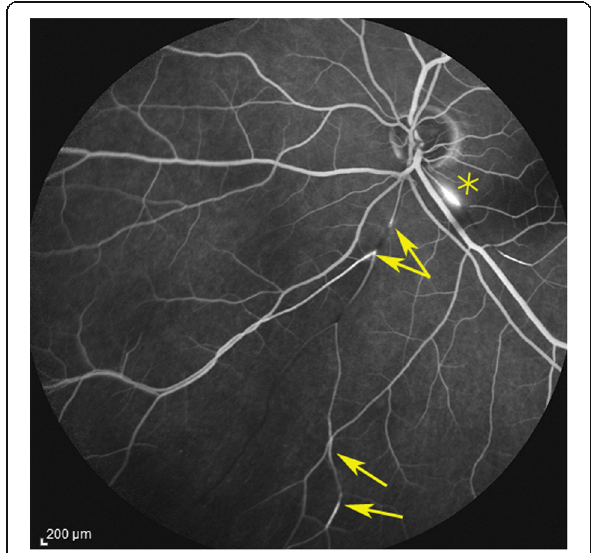
Fig. 5 Fluorescein angiography (FA) showing abrupt interruption of two arteries inferiorly (arrows) and characteristic arterial wall hyperfluorescence (asterisk) (case 1)